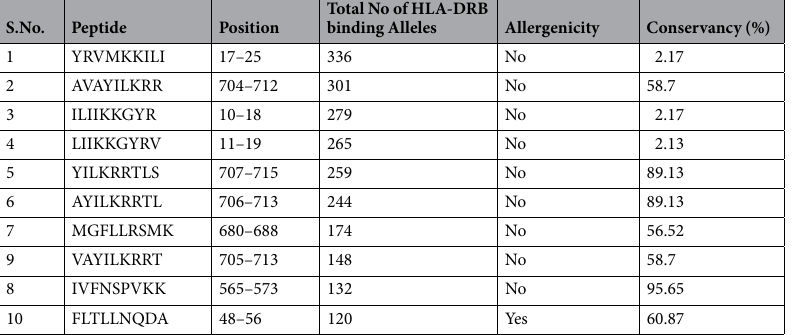
Table S4. Further, the molecular interaction analysis of these predicted CTL epitopes (other eight CTL epitoes) docked to HLA-A * 0201 protein are shown in supplementary Fig. S5. Also, the binding mode of each epitope to HLA-A * 0201 proteins for all 11 complexes are shown in supplementary Fig. S6. Thus including KTALGSYPY, all epitopes having weaker binding were treated as negative controls and used for the stability analysis along with the top three epitopes meeting additional criteria.